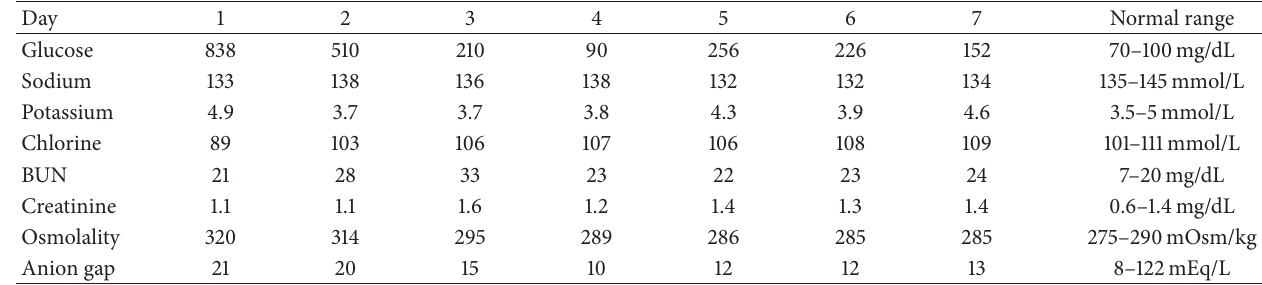
Table 1: Laboratory measures during